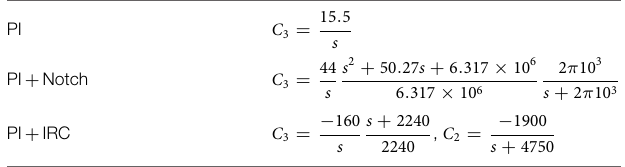
TABLE 1 | Summary of controller parameters .